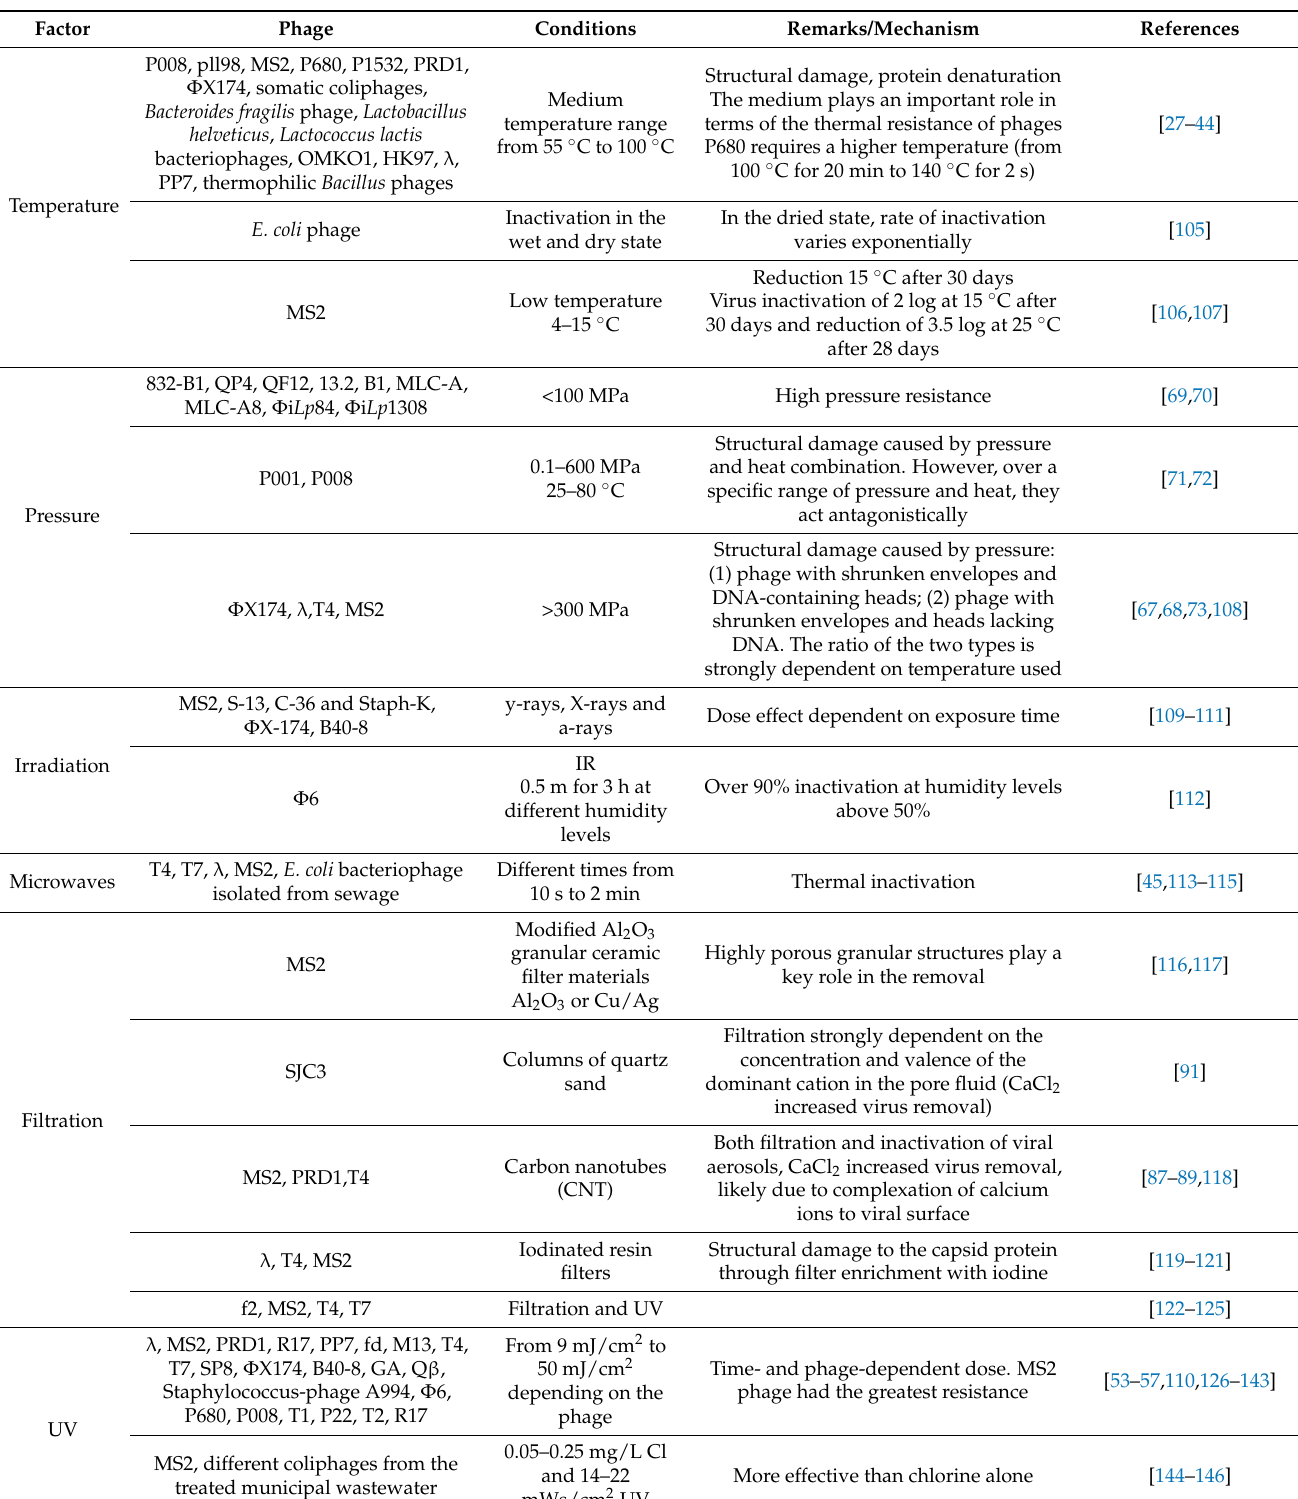
Table 2. The physical methods to eradicate